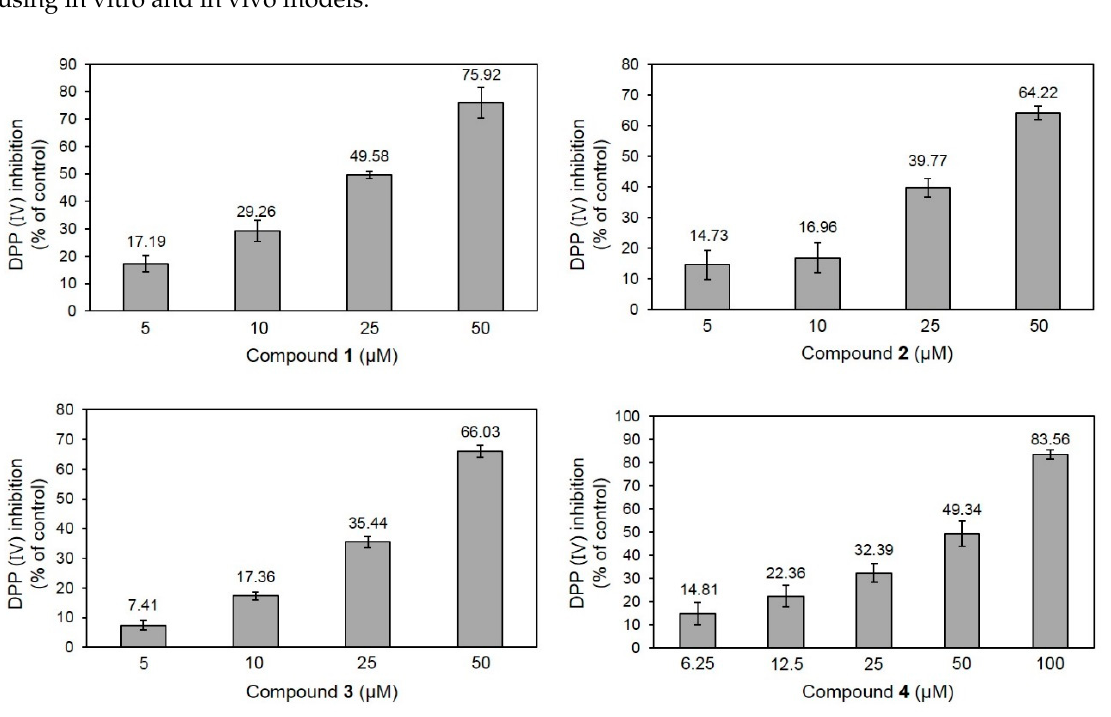
Figure 2. Effects of compounds 1 – 4 on dipeptidyl peptidase IV (DPP-IV) activity. Values are presented as the mean ± SD of three independent experiments.